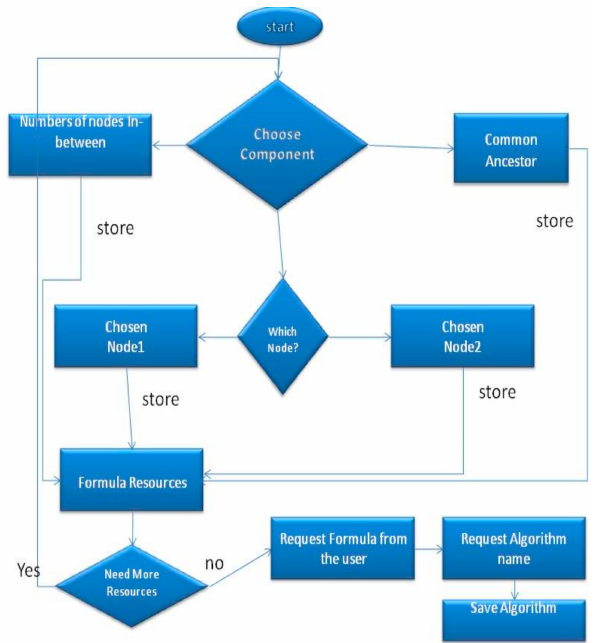
Figure 2. Information content